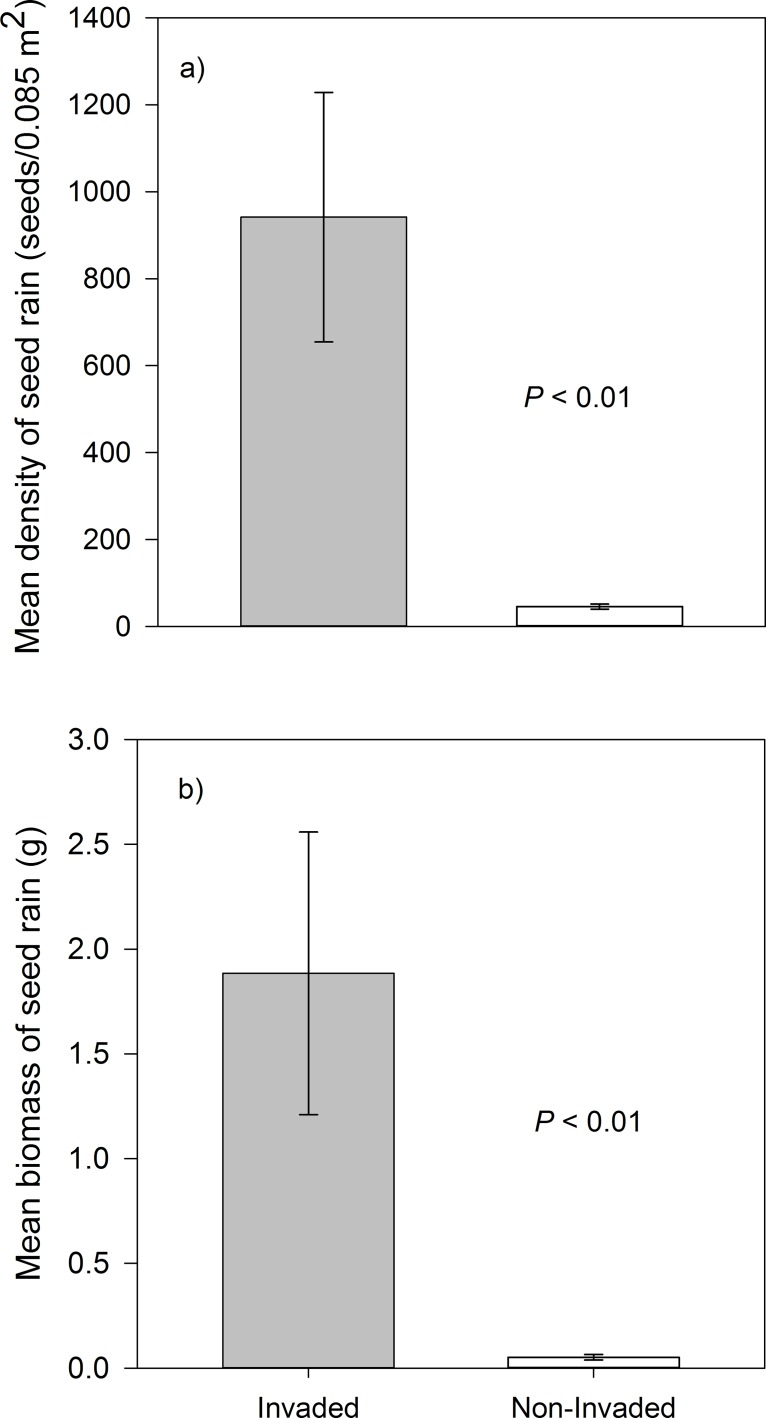
Seed Production on Cheatgrass-invaded vs. Non-invaded Habitat.Comparison of the a) density (seeds/0.085 m2) and b) biomass (g) of seed rain (mean ± SE) from cheatgrass-invaded (“Invaded”) and non-invaded (“Non-Invaded”) sage-steppe habitats in a Great Basin ecosystem (n = 6).